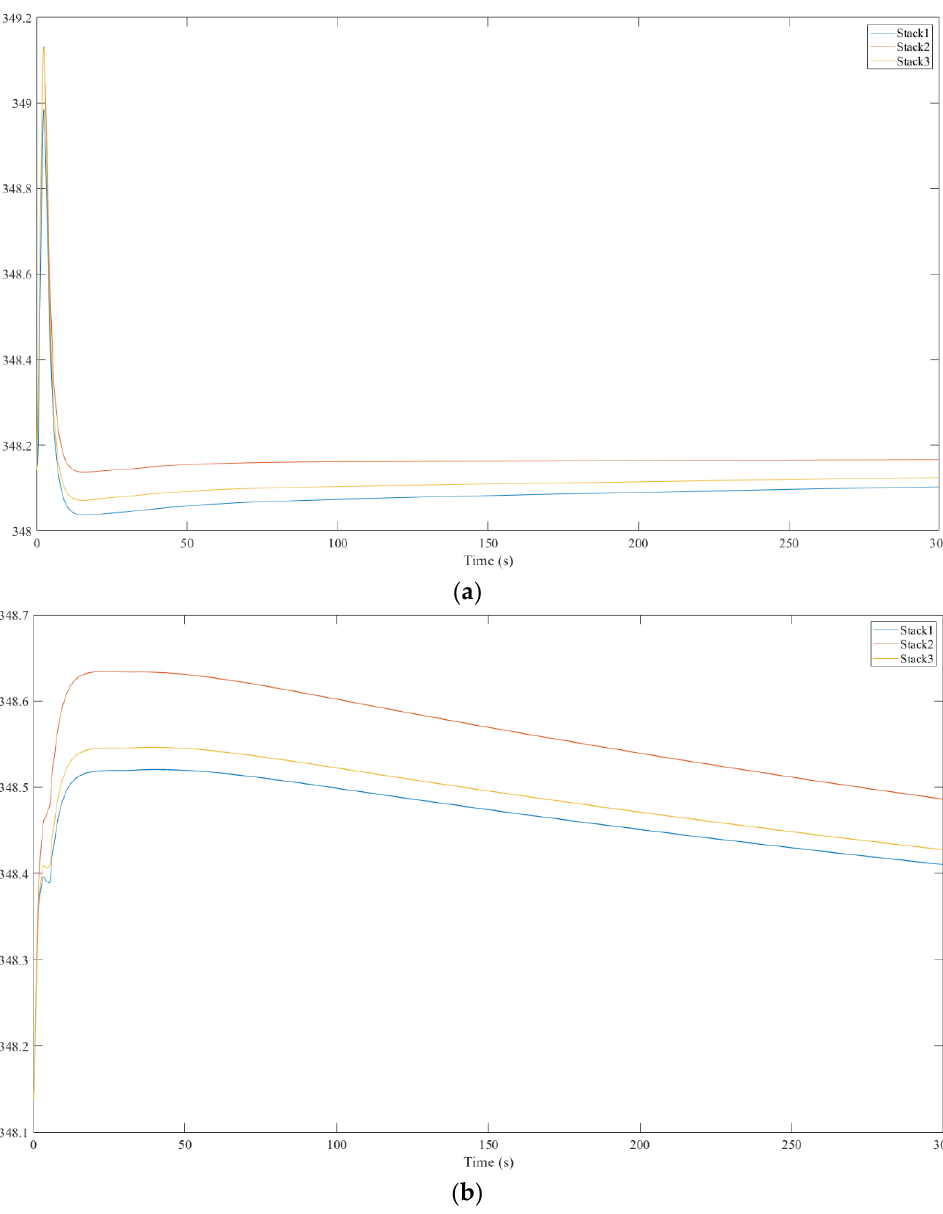
Figure 16. Three stacks ’ temperatures of the two topologies under steady working conditions: ( a ) distributed topology and ( b ) integrated topology.